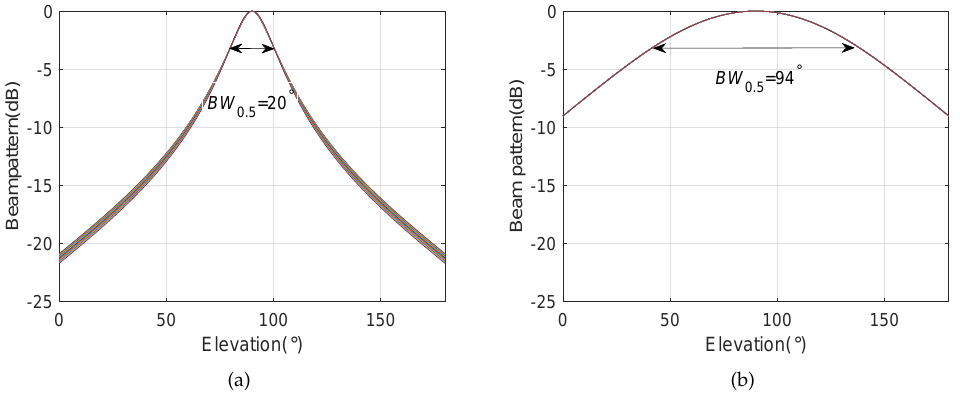
Figure 9. Beampattern in the elevation plane with the azimuth angle θ = 180 ◦ , where the beampattern is steered at φ s = 90 ◦ . ( a ) Coupling magnified BCAVSA; ( b ) original BCAVSA.